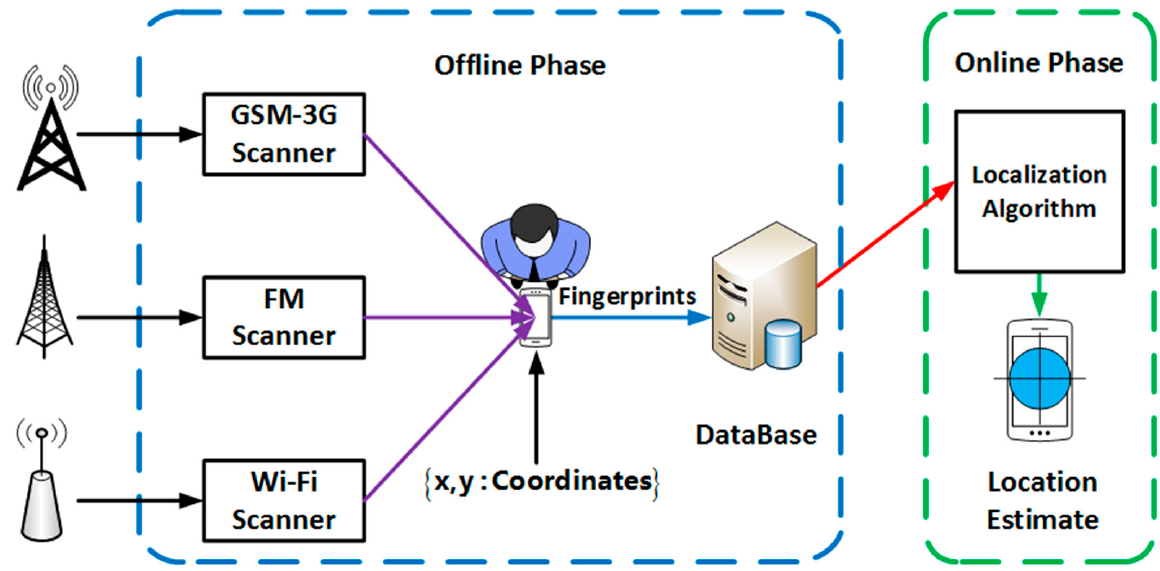
Figure 1. Fingerprint-based Localization System Architecture.